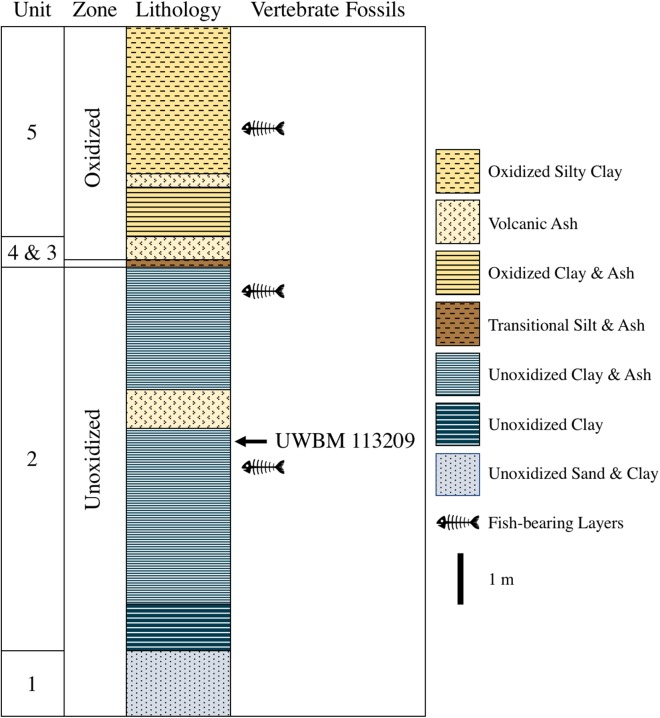
Stratigraphy of the Latah Formation exposed at UWBM C2830.Numbering, lithology, and color of units follows Smiley, Gray & Huggins (1975) and Smiley & Rember (1985a). The total thickness of the section exposed at the Kienbaum racetrack is roughly 9 m.